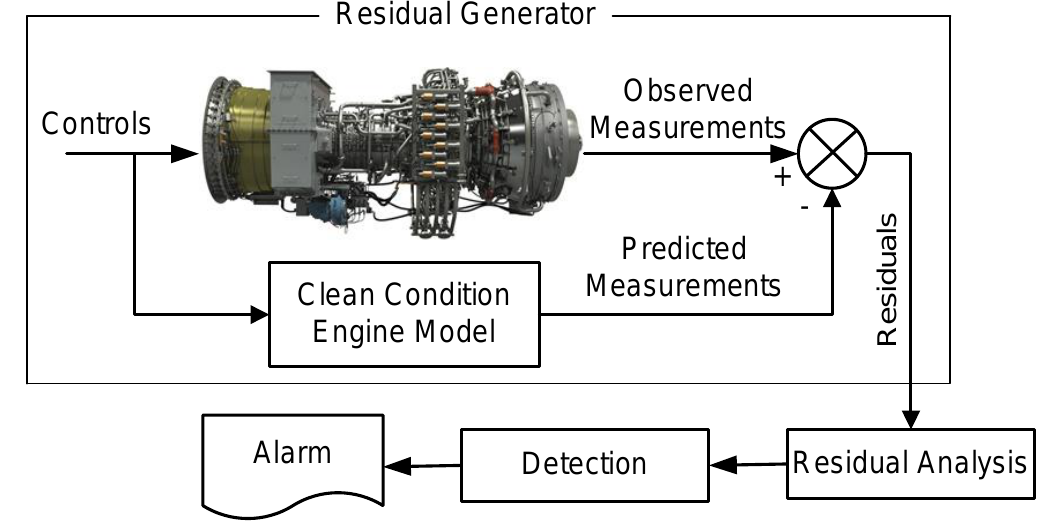
Figure 3. A general structure of residual based fault diagnosis procedure.